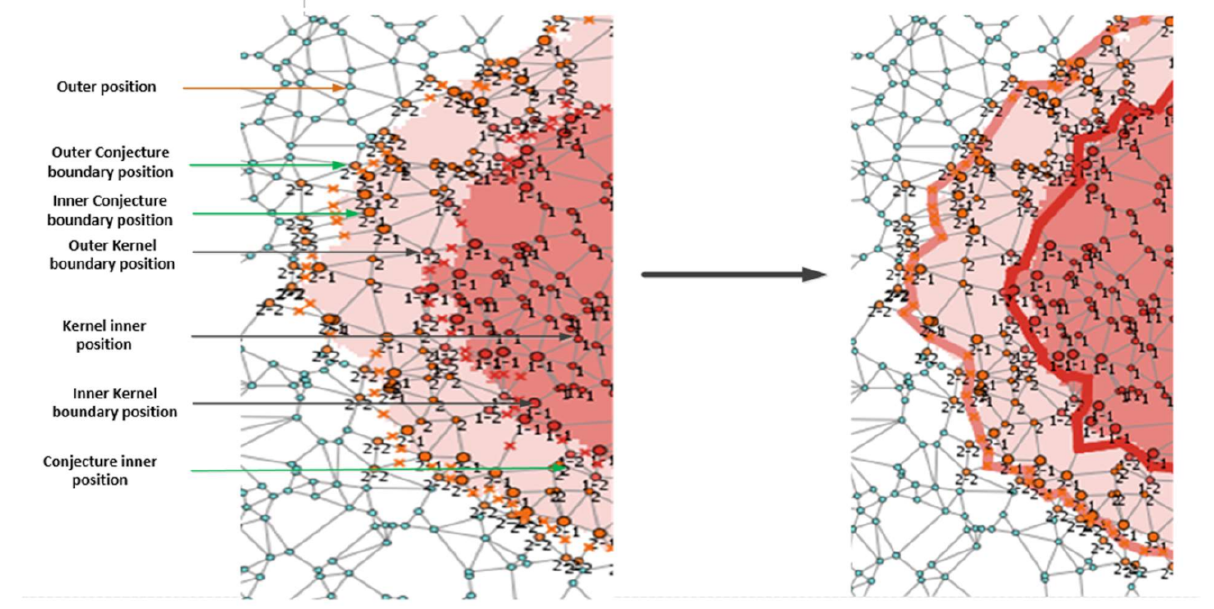
Figure 9. Excerpt of a sensor network showing A: nodes with border position and vertices of the kernel (red cross) and conjecture (orange cross); B: kernel and conjecture boundaries illustrated by red and orange lines crossing network